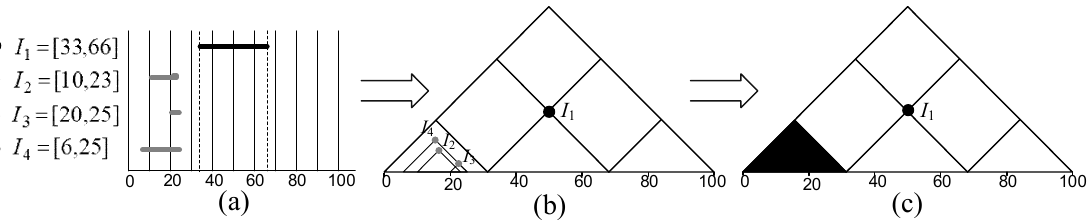
Figure 3. Representing temporal relations as spatial relations in the TM. ( a ) Time intervals ( I 1 - 4 ) in the linear model. ( b ) Time intervals ( I 1 - 4 ) in the TM. ( c ) the before zone of I 1 .